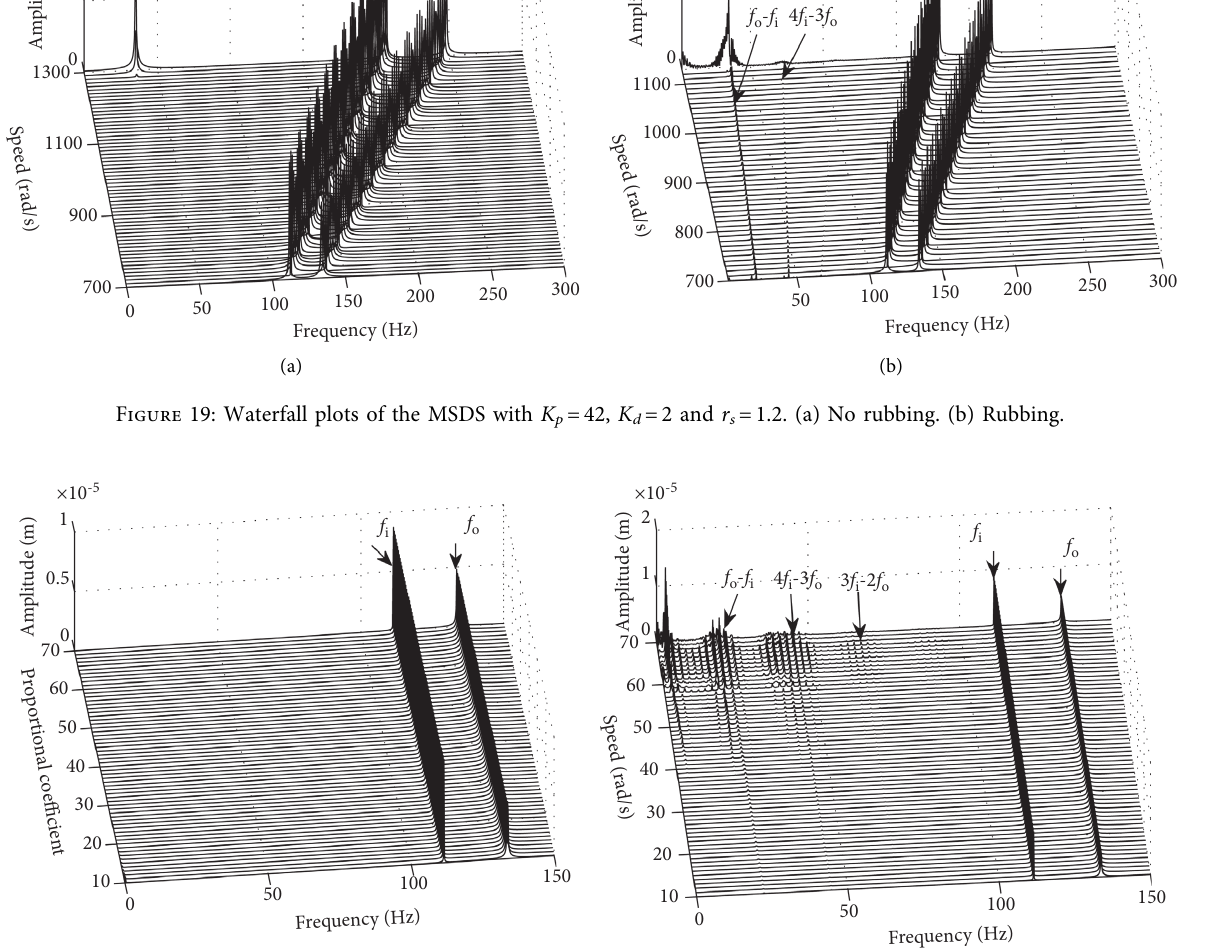
� 2, r � 1.2 and ω � 700rad/s. (a) No rubbing. (b) d s i